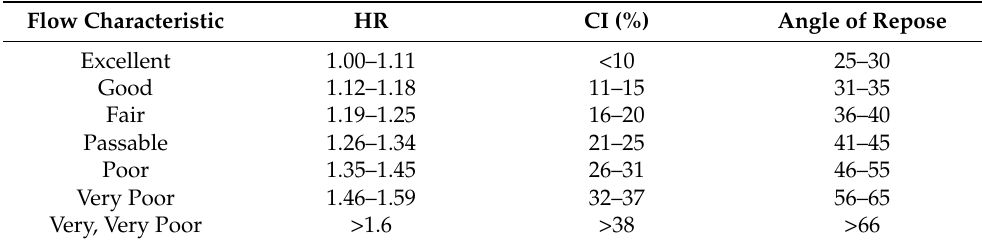
Table 2. Physicochemical properties of chickpea.